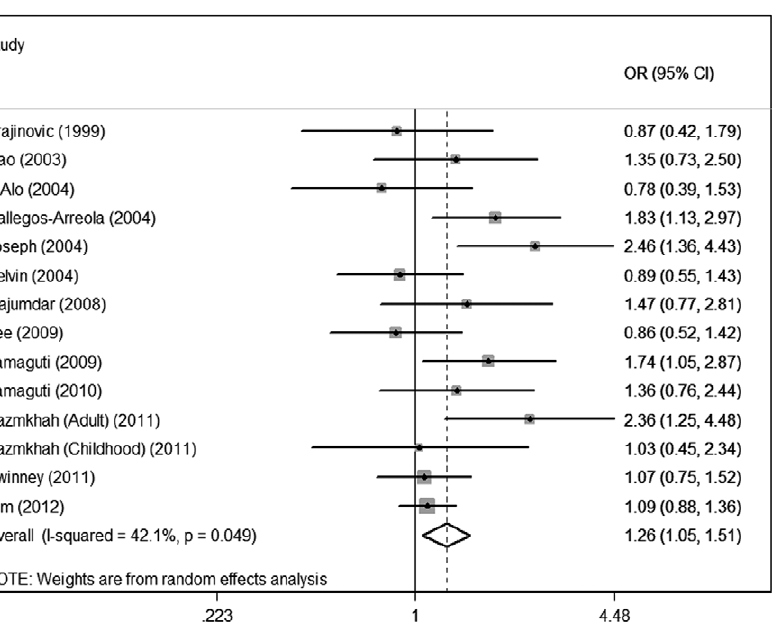
Figure 2. Meta-analysis for the association of acute leukemia risk with CYP1A1 Ile462Val polymorphism for the overall data (Val/ Val + Val/Ile versus Ile/Ile).